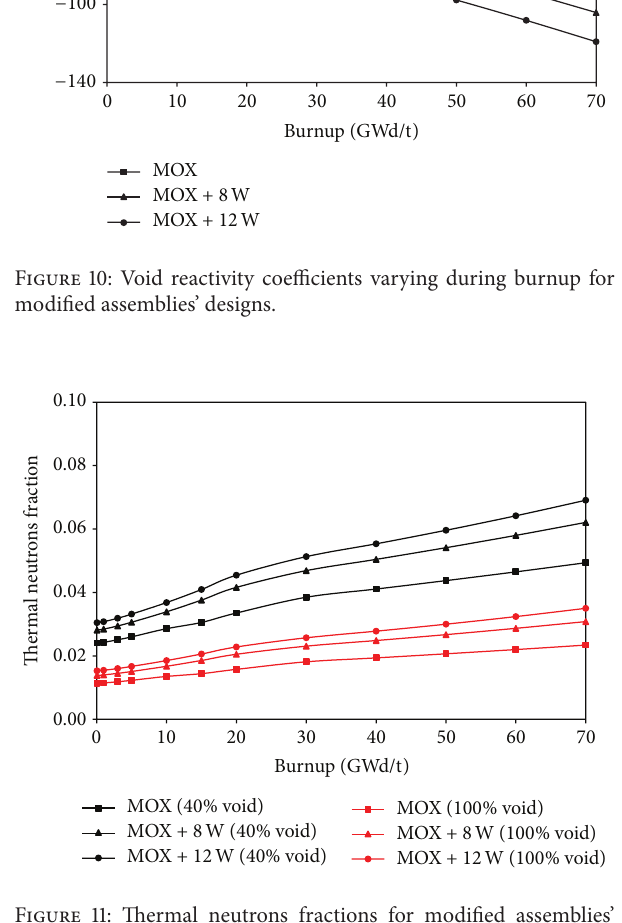
Figure 11: Thermal neutrons fractions for modified assemblies’